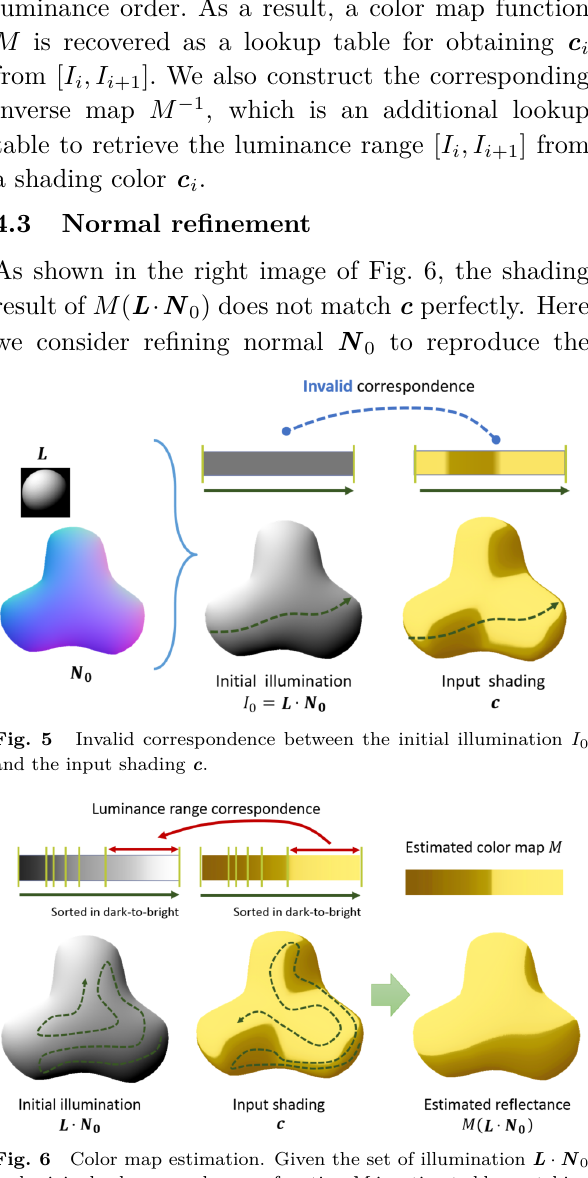
Fig. 4 Initial normal field obtained by silhouette inflation.